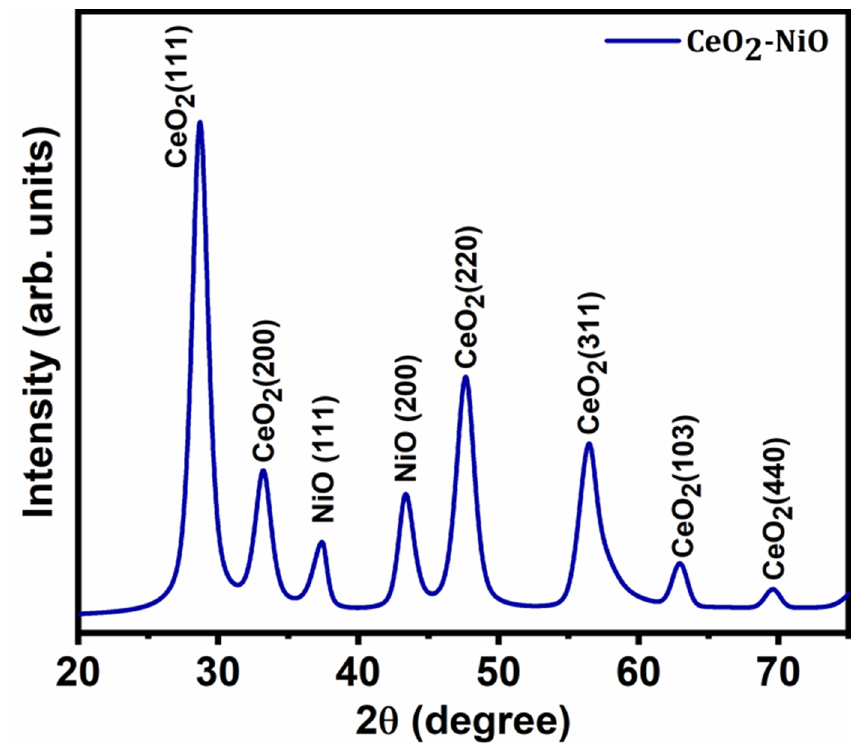
Figure 2. Indexed XRD pattern of CeO 2 /NiO nanocomposite.